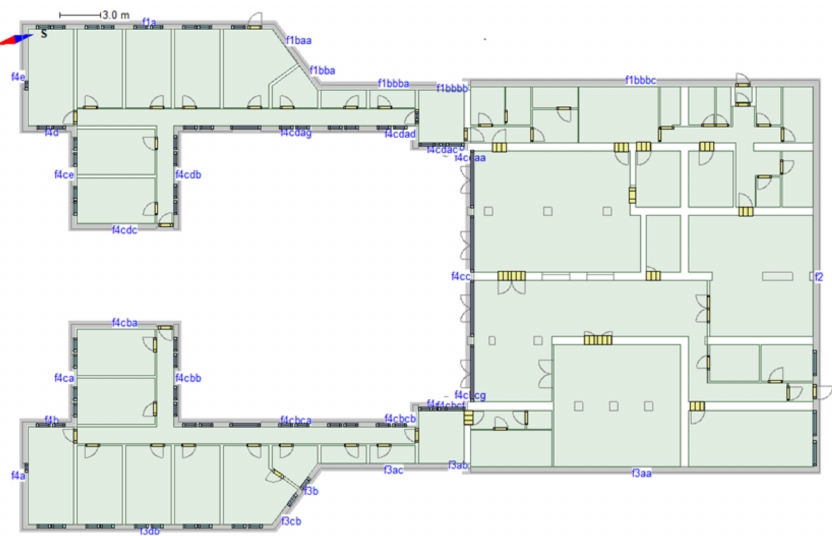
Figure 2. Floor plan of the analysed CEEE’s building of the Silesian Botanical Garden, Mikoł ó w, Poland, created in the IDA ICE